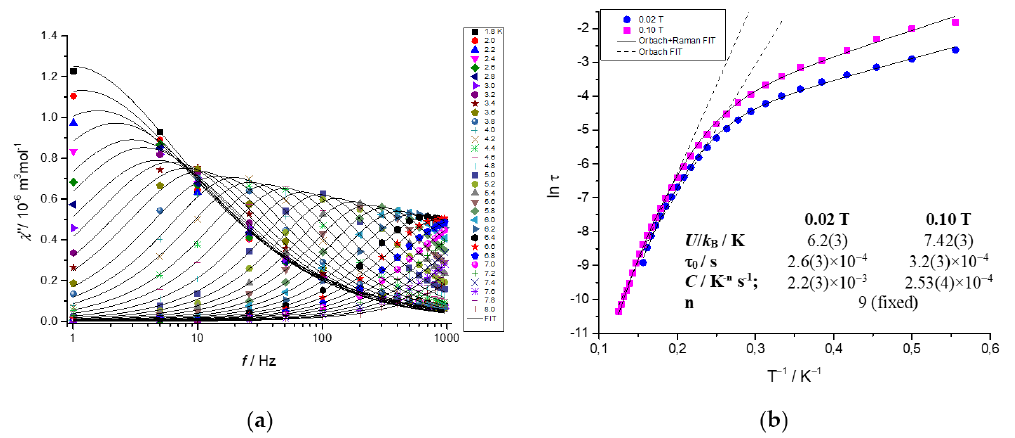
Figure 4. ( a ) Frequency dependent out-of-phase χ ″ components of AC susceptibility for compound I recorded at the applied static magnetic field B DC = 0.1 T (Solid lines present fits using the one-component Debye’s model, Equations (S1) and (S2); see Supplementary Materials); ( b ) The ln τ vs . 1/ T dependency obtained from AC susceptibility measurements at two static magnetic fields.